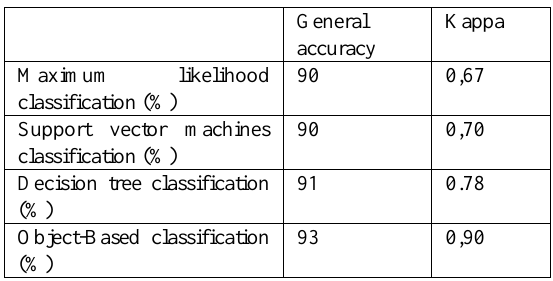
Chart 1. Pixel and Object based classification